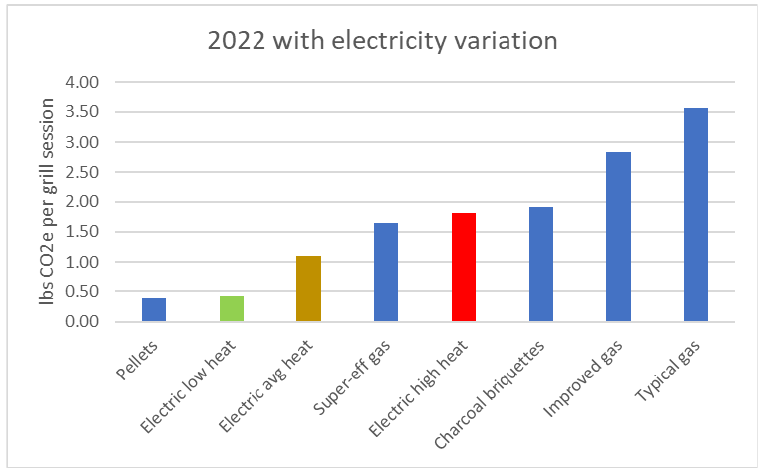
Figure 4. Grill-specific carbon footprints for grills, with high-low-average electricity, USA 2022.